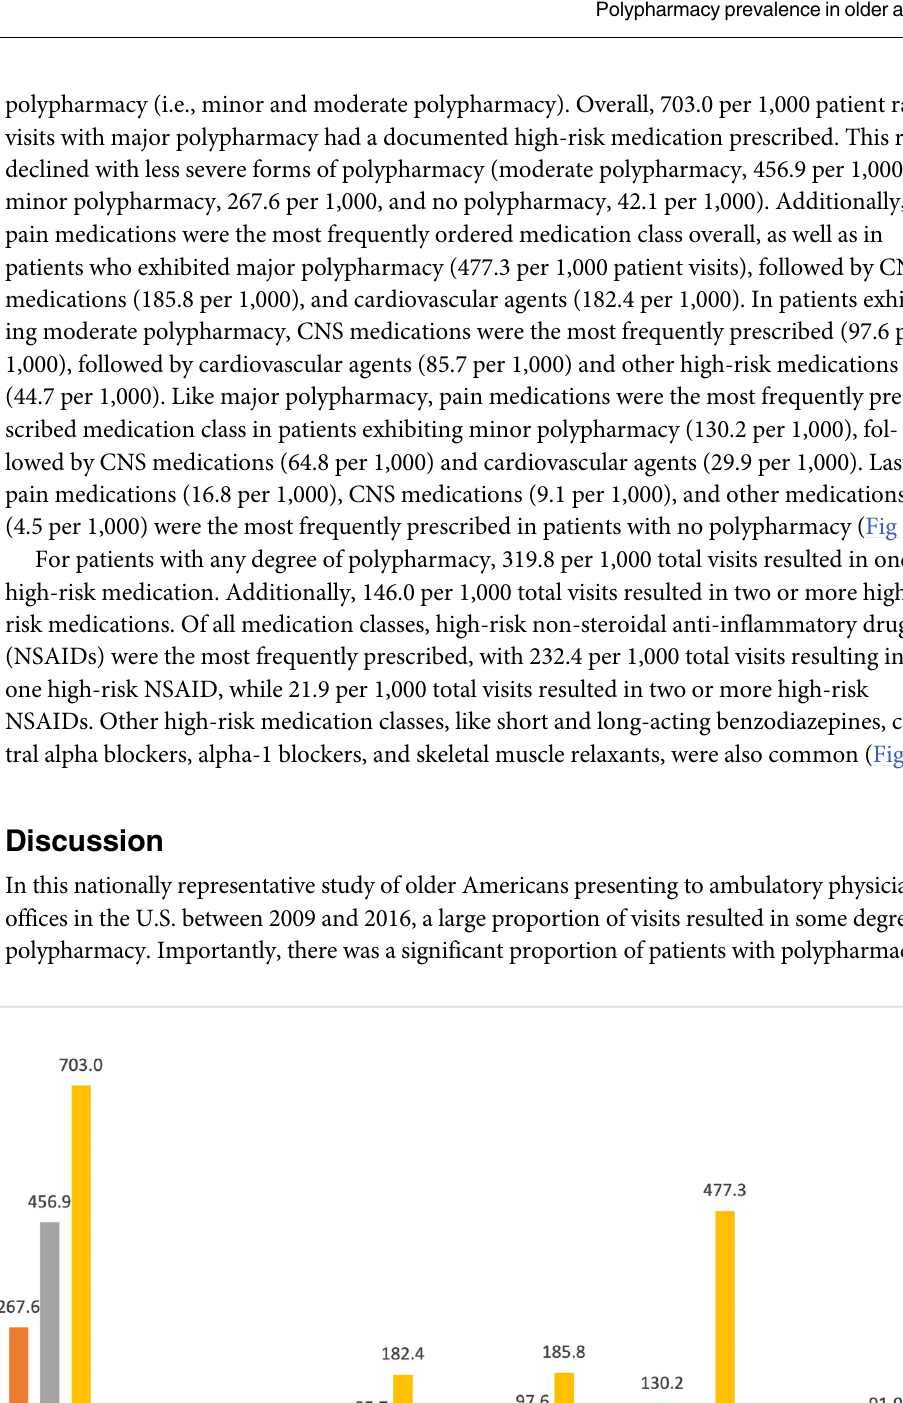
PLOS ONE | https://doi.org/10.1371/journal.pone.0255642 August 3,